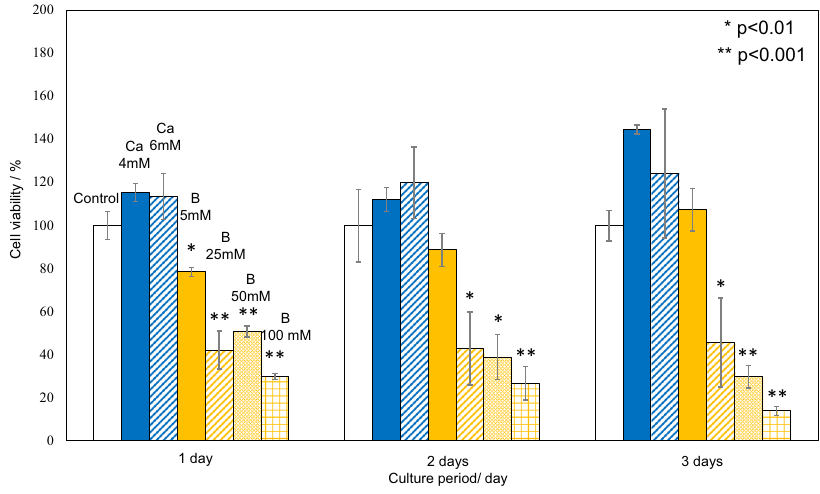
Fig. 8 Effect of low amount of calcium and borate ions on cell viability of L929 cells. *, **: statistical signi fi cant difference against